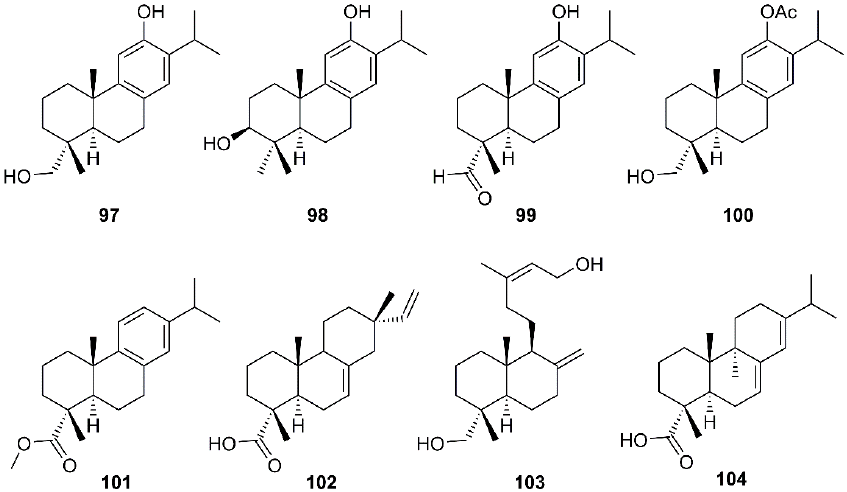
Figure 16. Structures of abietane ( 97 – 101 and 104 ), primarane ( 102 ), and labdane ( 103 ) diterpenoids.